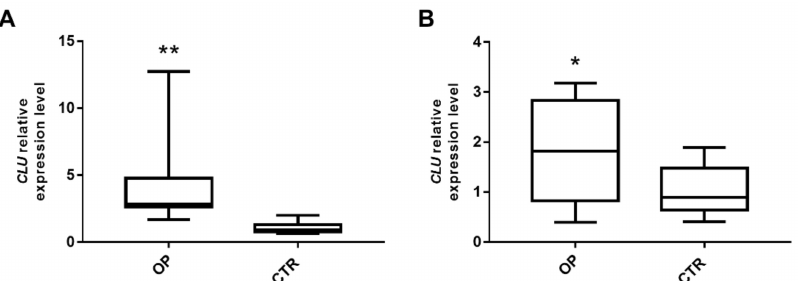
Figure 1. Expression of sCLU isoform from OP patients and CTR subjects. ( A ) CLU expression level was analyzed in osteoblasts from 7 OP patients and 7 CTR subjects. OP patients show an increased expression level of CLU with respect to CTR (** p < 0.01). ( B ) CLU expression level was analyzed in PBMCs from 30 OP and 30 CTR. OP samples show an increased expression level of CLU with respect to CTR (* p < 0.05). GAPDH mRNA level was used to normalize the relative amount of CLU and relative expression values are expressed as 2 − ∆∆ CT .